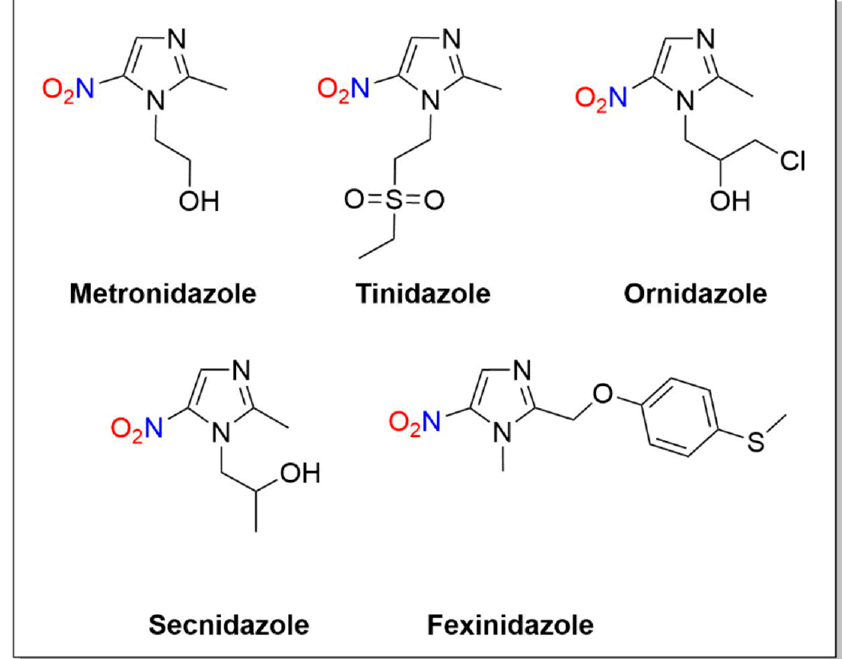
Figure 2. Structures of metronidazole, tinidazole, ornidazole, secnidazole and fexinidazole.